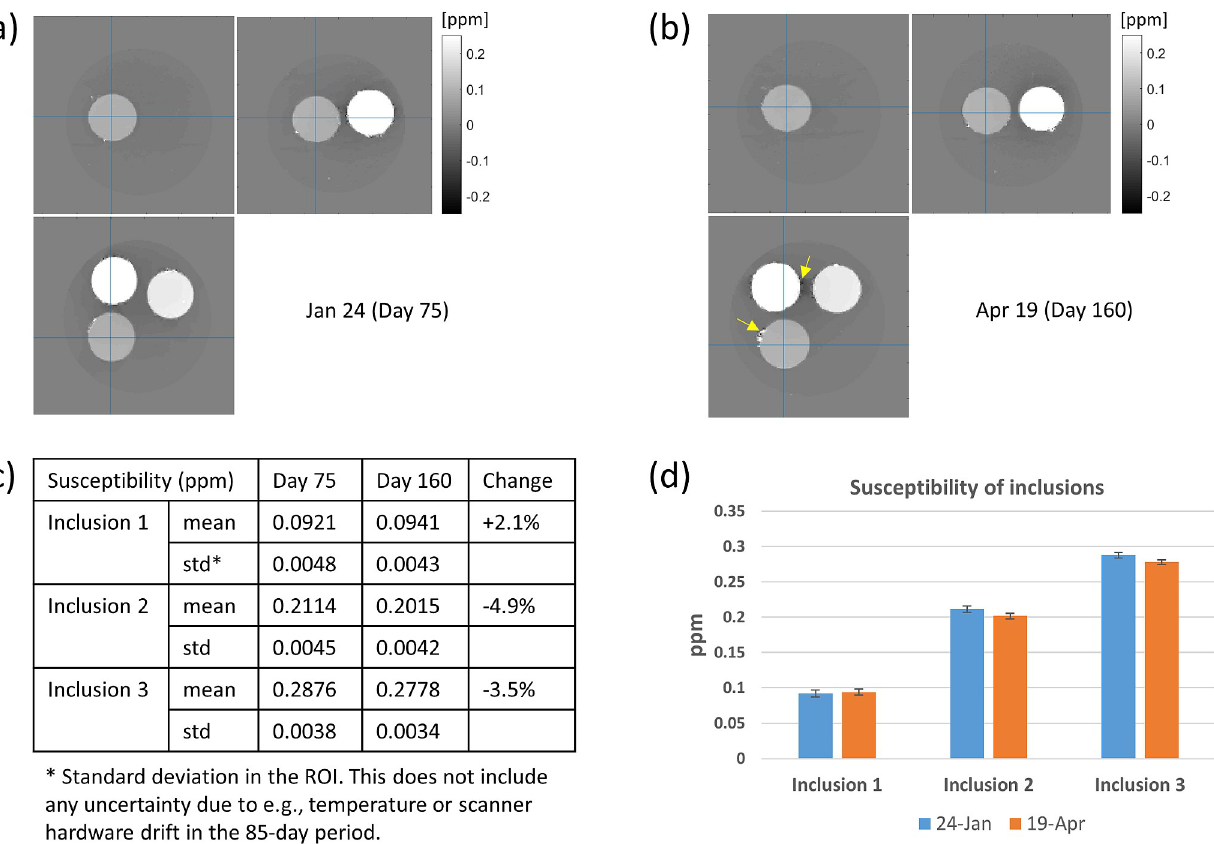
Fig 7. QSM by MEDI obtained with the same phantom 85 days apart. (a-b) 3 plane susceptibility maps; (a) is the same as in Fig 6B. Yellow arrows in (b) indicate additional surface defects. (c) Mean and standard deviation of susceptibility in each inclusion. (d) Plot of susceptibility, with error bars according to 1 std from